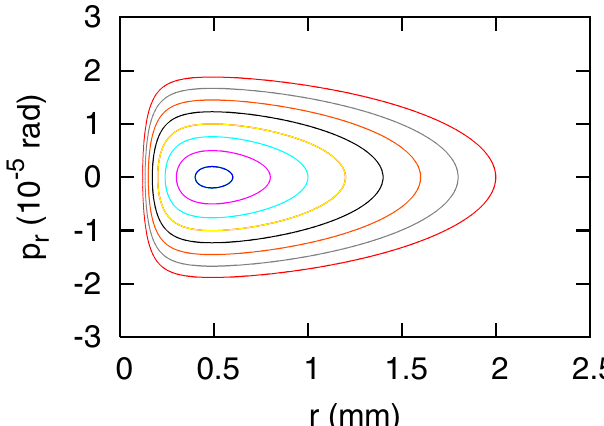
FIG. 2. (Color) Poincare´ plot in r (cid:1) p